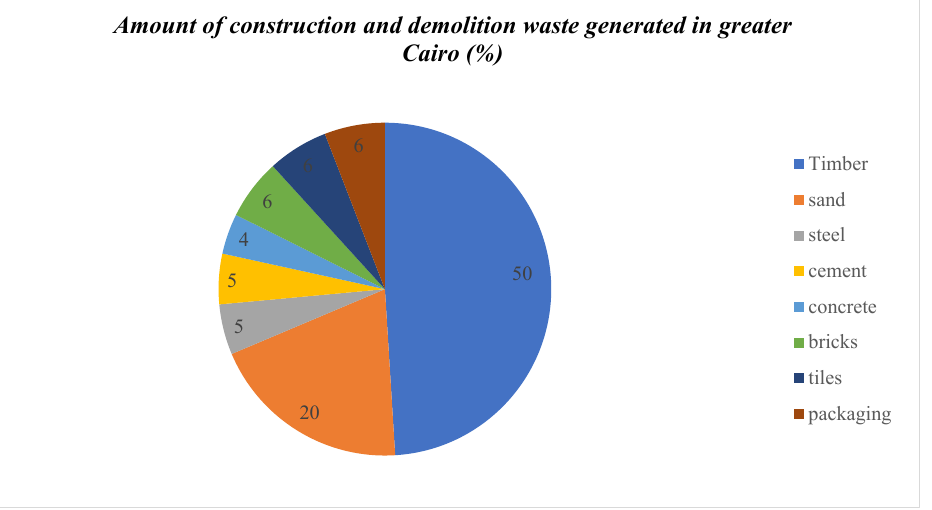
Figure 1. The amount of construction and demolition waste generated in greater Cairo.